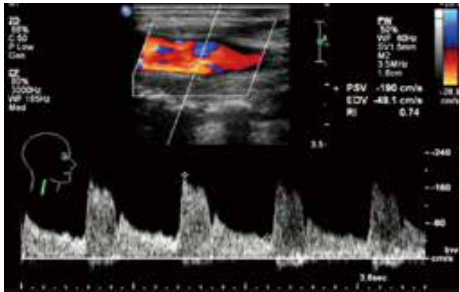
Figure 3 Localized aneurysm dilatation of the right common carotid artery.